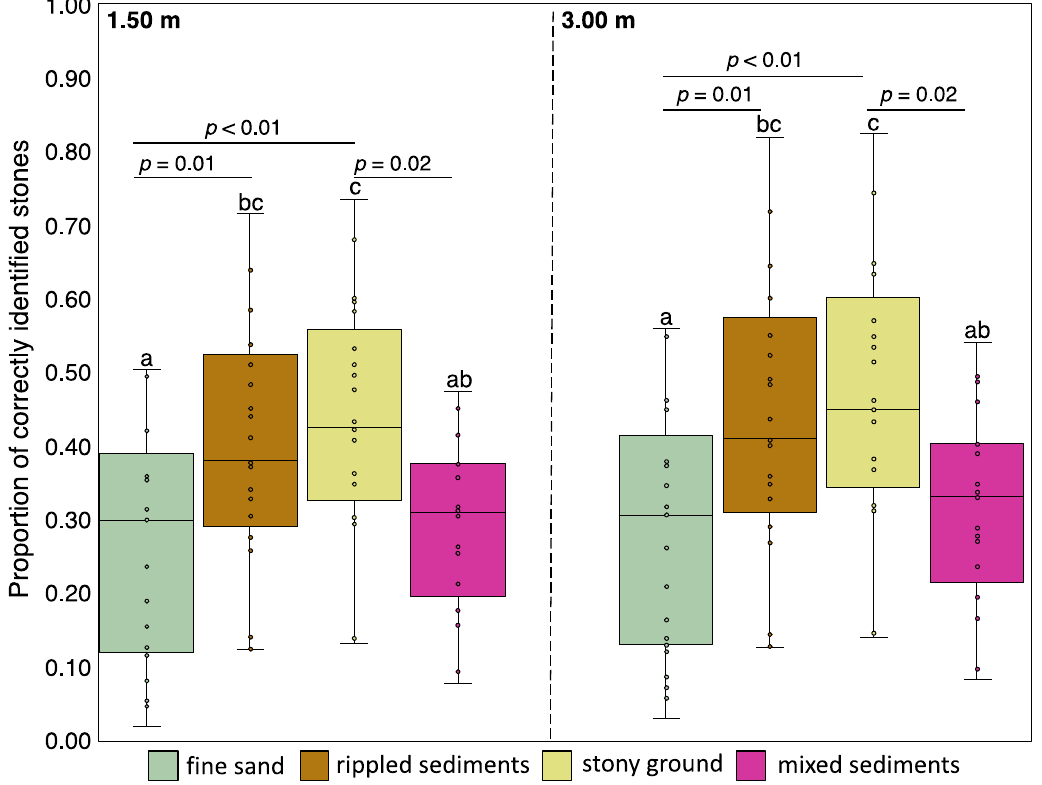
Figure 9. Boxplot and results of the Tukey–Kramer post-hoc test between the proportion of correctly identified stones (based on a buffer size of 1.50 and 3.00 m between the automatically and manually derived stones) and the sediment types fine sand, rippled sediments, stony ground and mixed sediments. Different letters within a buffer-size class indicate statistically significant differences at a significant level of p < 0.05.